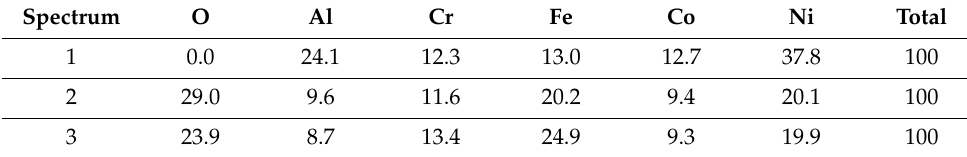
Figure 13. SEM-BSE images of the wear track edge after 100 h of aging at 800 ◦ C: ( a ) Oxide pile-up at the edge of the wear track; ( b ) Edge of the wear track showing no deformation by planar slip inside the L1 2 phase.